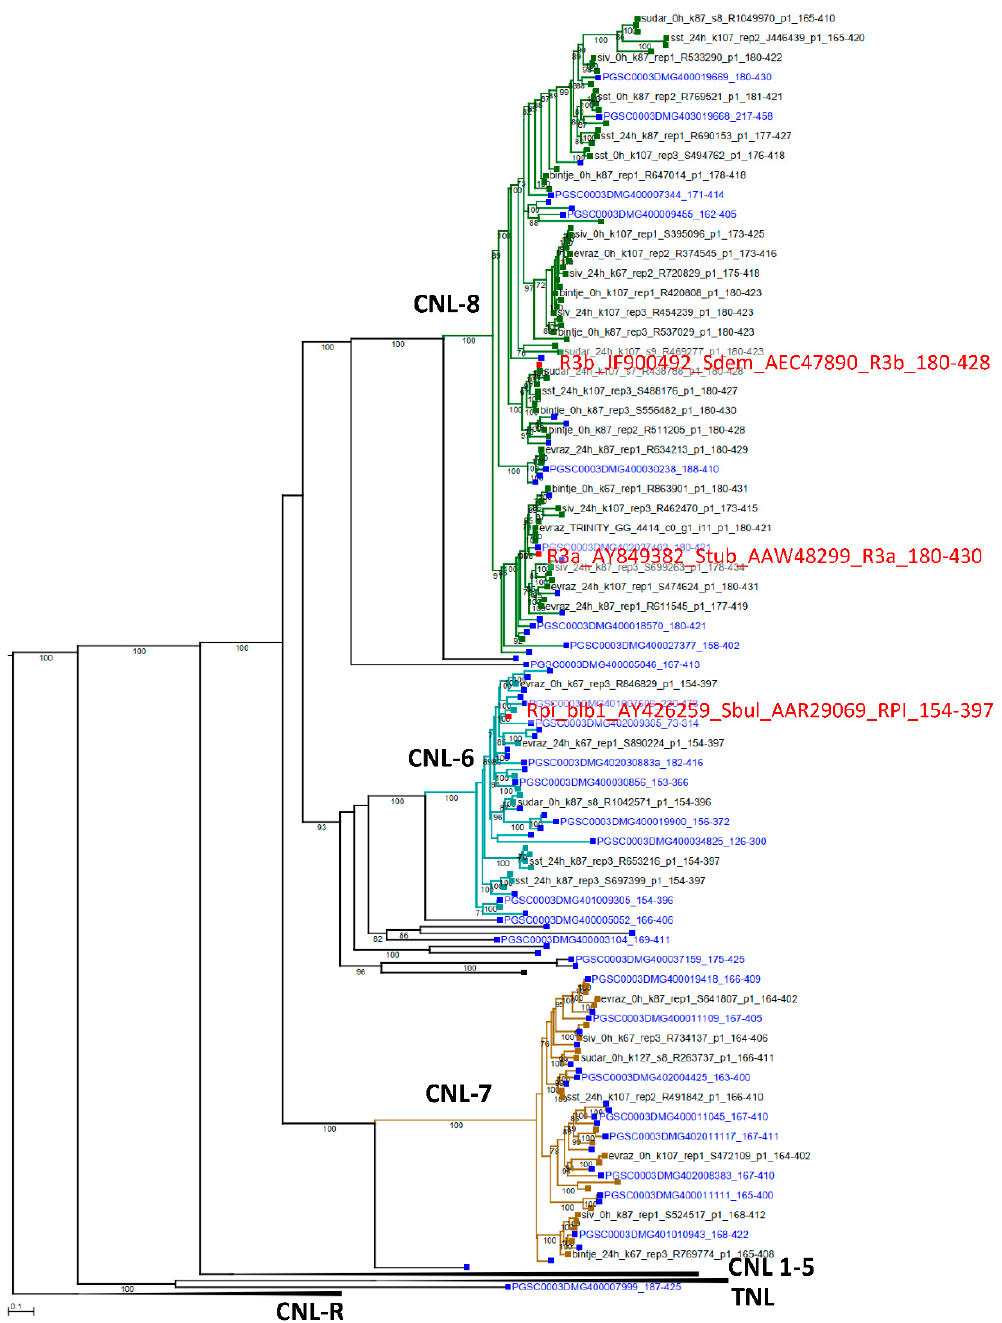
Figure 3. Fragment of the phylogenetic tree of NB-ARC domain containing proteins and their classes according to [13] (only clusters CNL-8, CNL-6, and CNL-7 are shown, classes TNL, CNL-R, and CNL 1–CNL 5 are collapsed; full phylogenetic tree is shown in the File S4). The IDs of known genes are highlighted in blue, wide-range resistance genes ( R3a , R3b , Rpi-blb1 ) are shown in red, and black color highlights the proteins IDs with no homology to the reference genome (novel NLR genes, File S3). Bootstrap support values greater than 70 are shown. The scale of branches lengths is provided at the bottom of the figure.